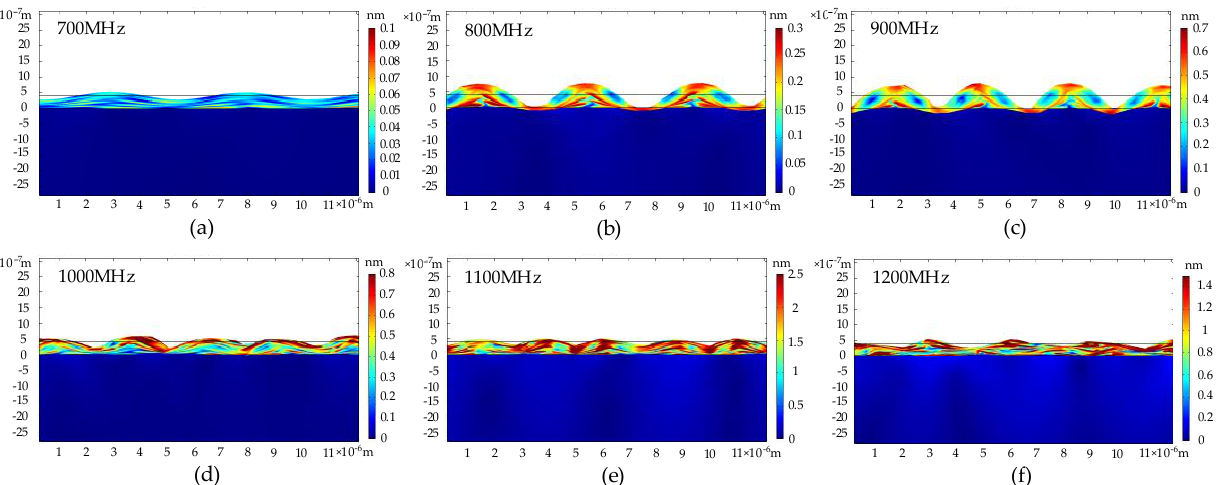
Figure 8. Relationship between displacement and frequency of the phonon piezoelectric device. ( a ) Diamond – ZnO interface; ( b ) inside the diamond; ( c ) IDT excitation tail; ( d ) IDT receiving tail. Figure 7 shows that the displacement inside the diamond substrate is negligible rel- ative to the mechanical displacement of ZnO. The acoustic wave energy decays rapidly in the thickness direction of the substrate. It is concentrated on two wavelength scales. The acoustic wavelengths in the ZnO piezoelectric layer are 5.3 × 10 − 6 m, 4.2 × 10 − 6 m, 3.2 × 10 − 6 m, 2.7 × 10 − 6 m, 2.4 × 10 − 6 m, and 2.2 × 10 − 6 m at the resonant frequencies of 700 MHz, 800 MHz, 900 MHz, 1000 MHz, 1100 MHz, and 1200 MHz. The maximum displacements of the acoustic waves are 0.1 nm, 0.3 nm, 0.7 nm, 0.8 nm, 2.5 nm, and 1.4 nm, respectively. Figure 8a – d correspond to the average particle displacements at the interface of the dia- mond and ZnO piezoelectric membrane inside the diamond at the IDT excitation tail and